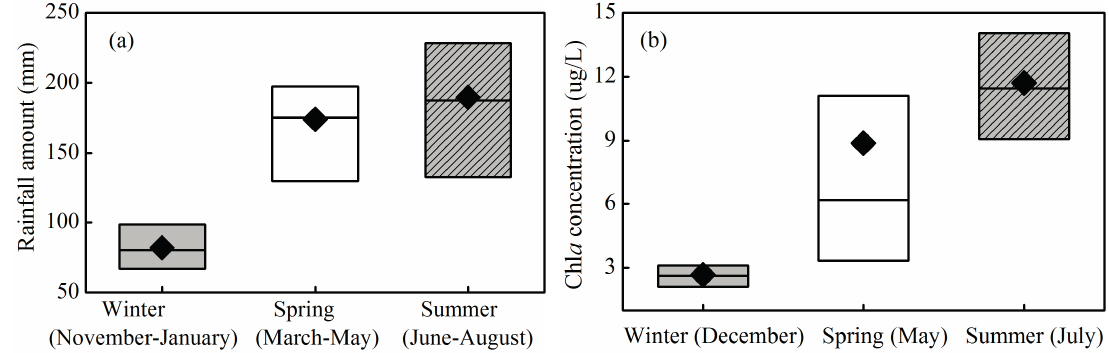
Figure 5. Boxplots of the monthly average rainfall in Xin’anjiang Reservoir for the long-term observations over the 26-year period (1988 to 2013) ( a ) and the chlorophyll a concentration ( b ) for the short-term observations from 2013 to 2014. The box is determined by the 25th and 75th percentiles, and the values of the median (horizontal line) and mean (diamond) are also